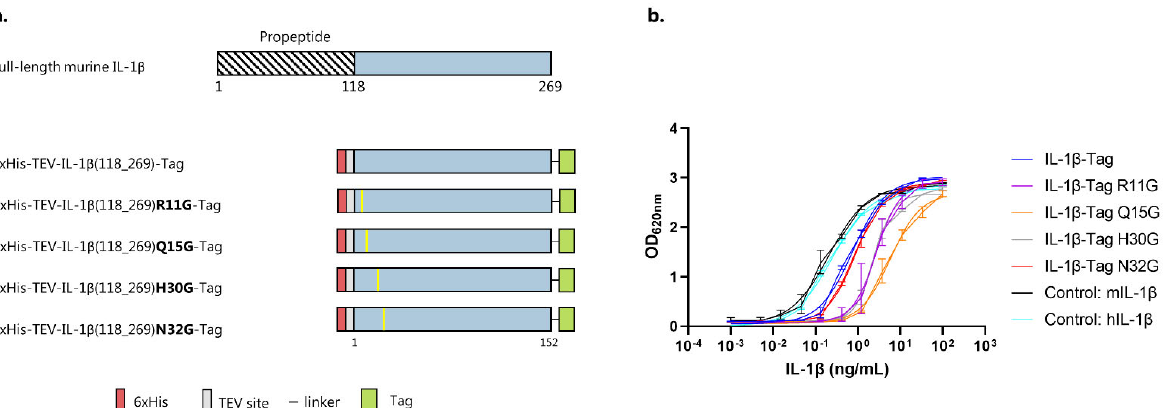
Figure 1. IL-1 β antigen design. ( a ) Graphical representation of full-length (FL) murine IL-1 β and the five IL-1 β antigen constructs. FL murine IL-1 β consists of a pro-peptide (aa1-117) that is cleaved to release the mature active 17kDa IL-1 β protein (blue). The muIL-1 β antigens were N-terminally fused to a 6xHis-tag (red), followed by a TEV site (gray). A split-protein binding Tag (green) was added to the C-terminus of the antigen, separated by a flexible linker. Mutations (yellow) were introduced into the WT sequence to reduce the affinity of the antigens for IL-1R1. ( b ) A HEK293 cell assay was used to assess the biological activity of the produced protein antigens. A dilution series of the IL-1 β proteins (3-fold, starting from 100 ng/mL) was added to engineered HEK293 cells, and the biological activity was estimated based on SEAP detection (620 nm) after overnight incubation. Tested antigens include IL ‐ 1 β‐ Tag (blue, EC 50 = 0.75), IL ‐ 1 β (R11G) ‐ Tag (magenta, EC 50 = 2.7), IL ‐ 1 β (Q15G) ‐ Tag (orange, EC 50 = 5.8), IL ‐ 1 β (H30G) ‐ Tag (grey, EC 50 = 2.4), IL ‐ 1 β (N32G) ‐ Tag (red, EC 50 = 0.89). Positive controls include, muIL ‐ 1 β (black, EC 50 = 0.21) and huIL ‐ 1 β (cyan, EC 50 = 0.25). A technical replicate of this assay